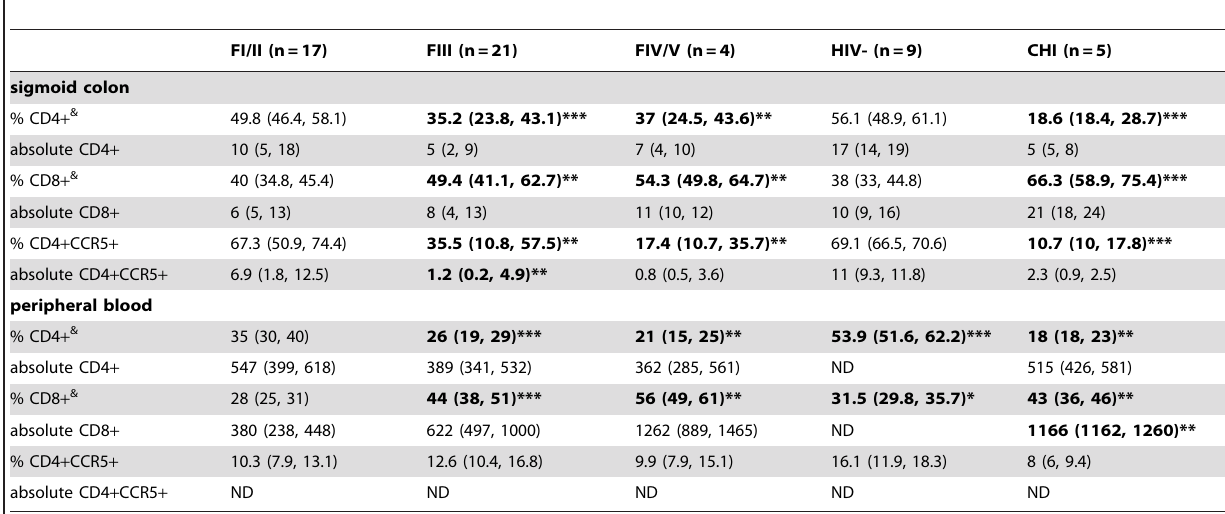
Table 2. Proportion and absolute number of CD4 + , CD4 + CCR5 + and CD8 + T cells in sigmoid colon and peripheral blood at baseline in HIV-, FI/II, FIII, FIV/V and CHI